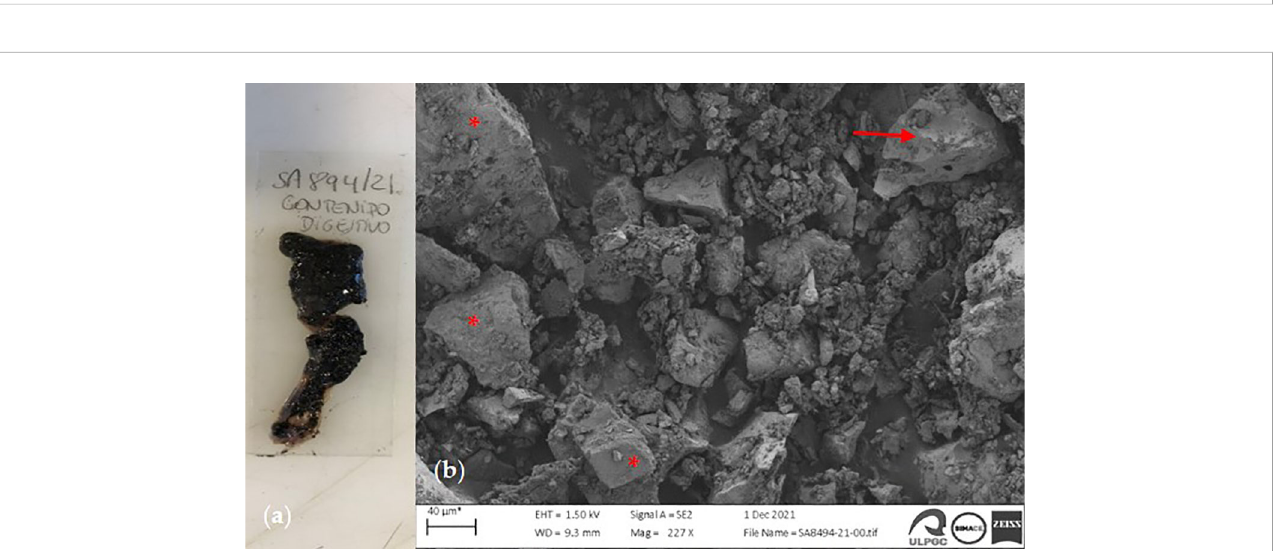
FIGURE 6 (A) Digestive content from a Sparisoma cretense . (B) Digestive content under the scanning electron microscope. (*) presence of angular and low- vesiculated fragments derivated of the fragmentation of the lava fl ows when entered to the sea (identi fi ed as hyaloclastites). ( ! ) presence of vesiculated particles, falling into the sea-surface from the dispersion of the subaerial eruptive column (identi fi ed as ashes).